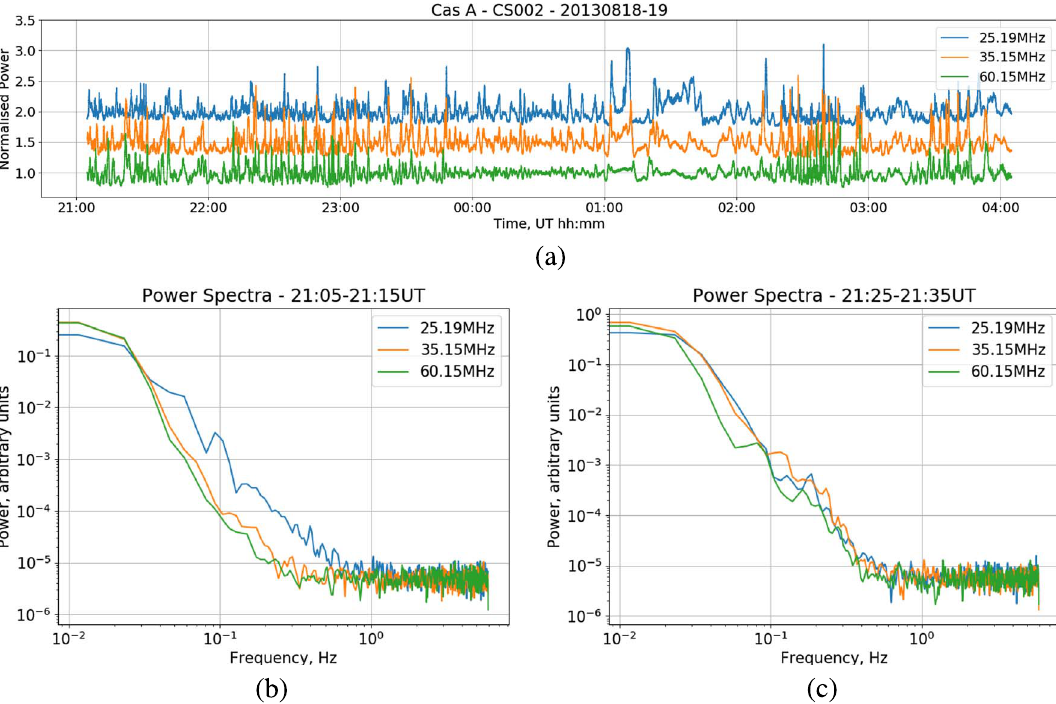
Fig. 1. (a) Time series of intensity received at three discrete frequencies by LOFAR station CS002 during the observation of Cas A on 18 – 19 August 2013, plus, (b) and (c) power spectra of two 10-min periods within these time series ’